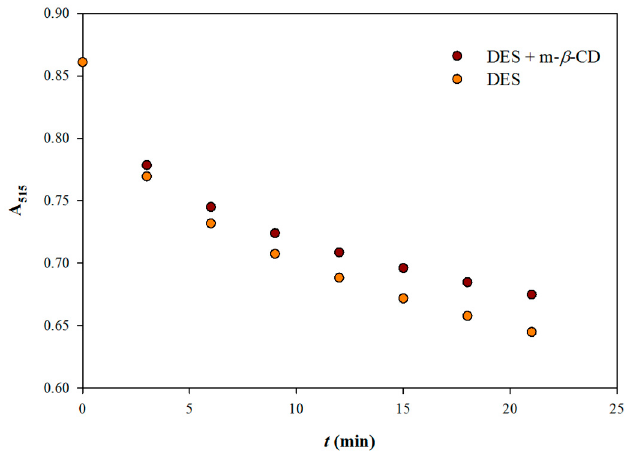
Figure 2. Extended reaction kinetics recorded upon mixing OLL extract with DPPH. C TP was adjusted to 0.1 g L − 1 , c 0 was 100 µ mol L − 1 .